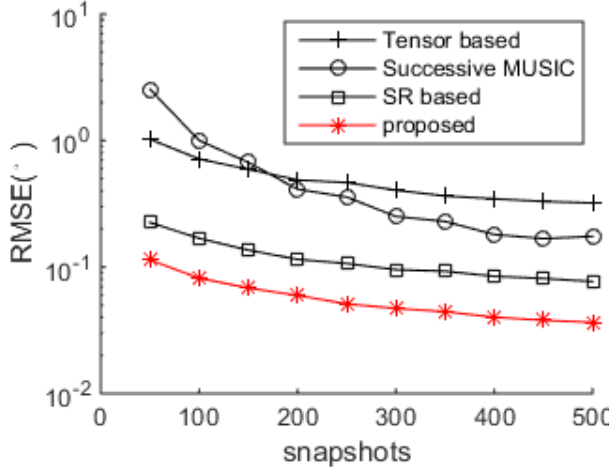
Figure 5. DOA estimation performance comparison versus snapshots (SNR= 0dB).